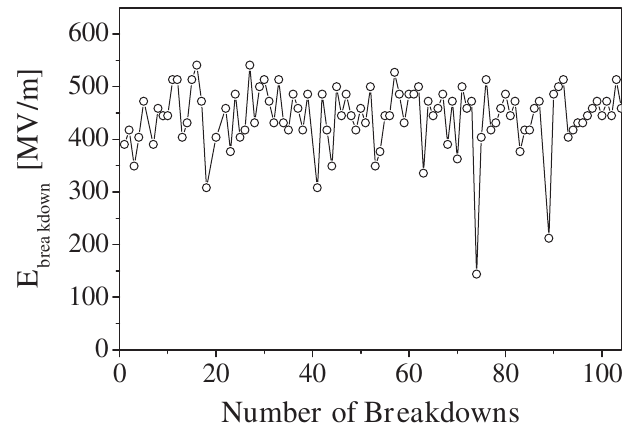
FIG. 5. Breakdown conditioning after ex situ heat treatments of molybdenum to temperatures (cid:4) (cid:1) 1200 K in vacuum ( p < 10 (cid:2) 4 mbar ), followed by more than 4 h in atmospheric air. are determined to be (cid:9) 459 (cid:8) 2 (cid:10) MV = m . The E sat